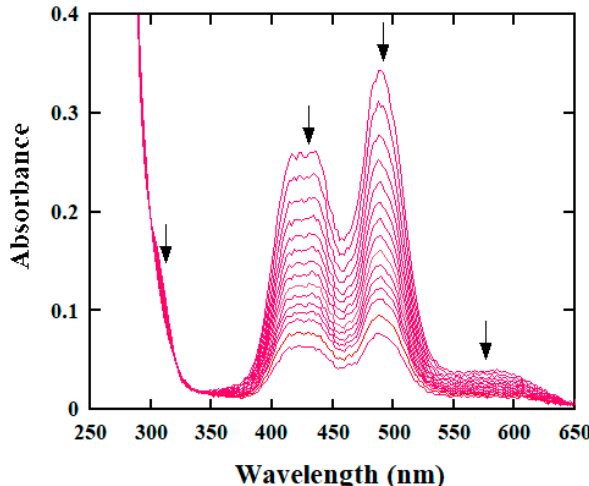
Figure 1. Rapid scan spectra obtained for the oxidation of benz(o)hydrazide (BH) by [IrCl 6 ] 2 − under the reaction conditions: [Ir(IV)] = 0.20 mM, [BH] tot = 3.00 mM, phosphate bu ff er of pH 5.10, µ = 1.0 M and 25.0 ◦ C. The spectra were acquired at 3, 33, 63, 92, 123, 152, 182, 212, 242, 273, 303, 332, 364, 423, and 500 milliseconds after the start of the